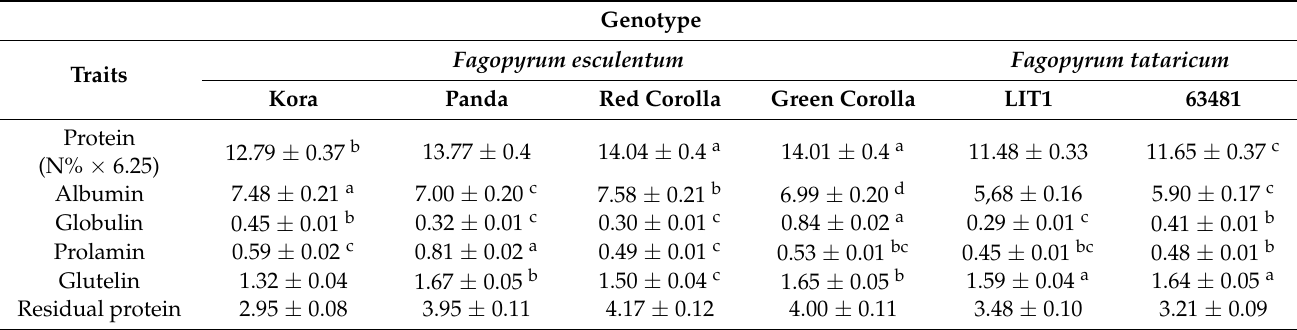
Figure 3. Proportion (%) of protein fractions in buckwheat genotypes (protein = 100%). Table 3. Mean values of protein content and distribution of protein fractions in the studied buckwheat genotypes (g/100 g d.m.). Genotype Fagopyrum esculentum Fagopyrum Traits